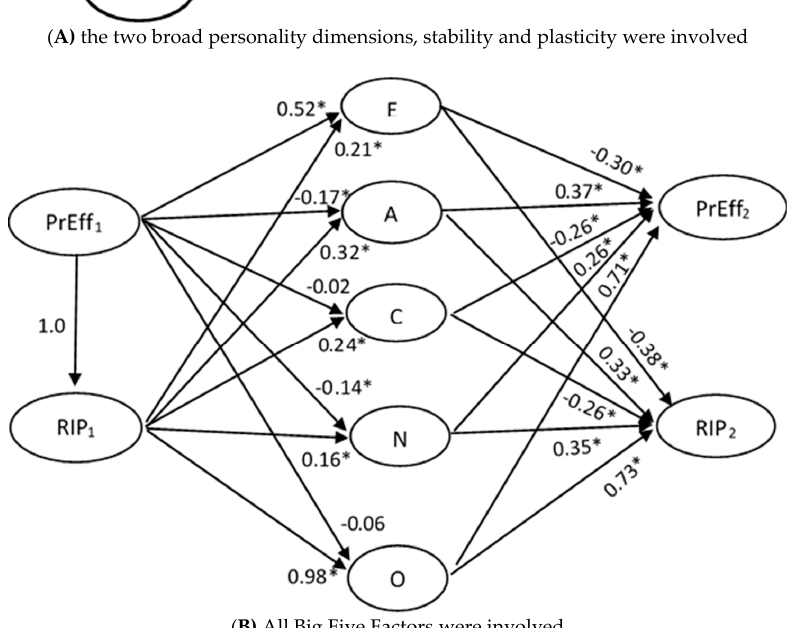
Figure 6. Cross-lagged models (panel A and B) of the mediation of personality factors of stability ( α -factor) and plasticity ( β -factor) between processing efficiency (PrEf) and representational and inferential power (RIP) at first and second testing wave (1 and 2). Note: Models A and B are fully presented in Supplementary Materials, Study 2, Models 2 and 3, respectively).